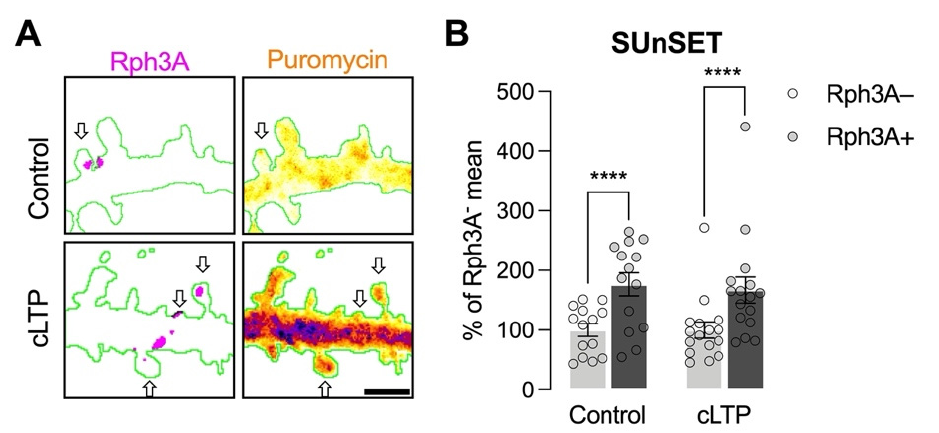
Figure 1. Analysis of the role of Rph3A in protein translation at dendritic spines. ( A ): Confocal images of dendritic spines shown by a fluorescent filler (GFP, green), Rph3A staining (red), and puromycin (rainbow), as well as a merged image (right panels). Arrows point out Rph3A+ spines. Scale bar: 1 µ m. ( B ): Bar graph representation of mean ± SEM puromycin levels in Rph3A − (light grey) and Rph3A+ (dark grey) spines under control conditions or after cLTP induction. The data are expressed as a percentage of Rph3A − mean puromycin levels. Rph3A+ control vs. Rph3A − control: Paired t -test; Rph3A+ cLTP vs. Rph3A − , cLTP: Wilcoxon test. **** p < 0.0001. Dots represent single values.